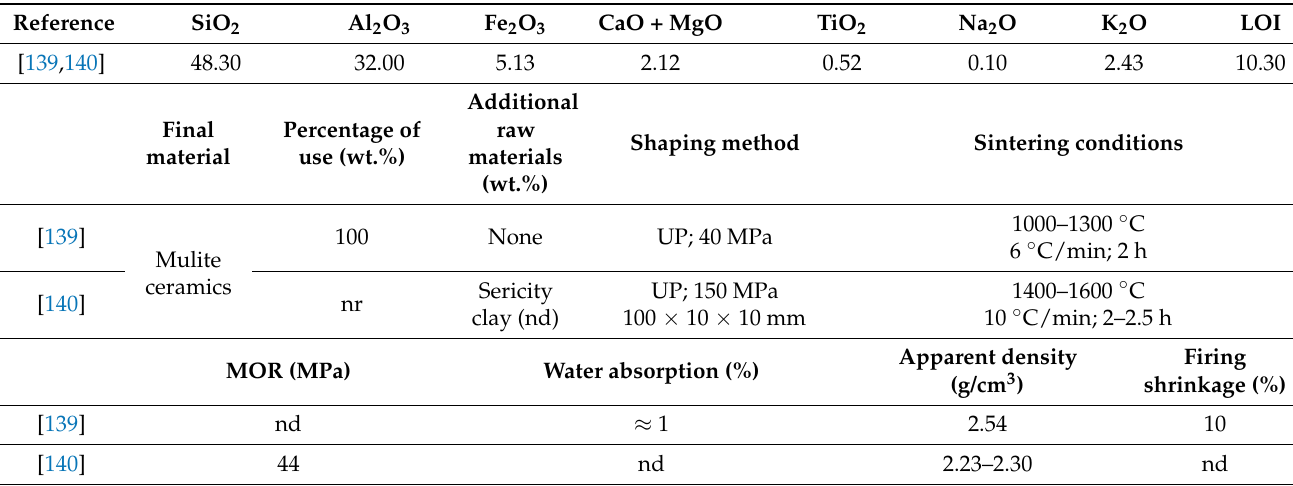
Table 18. Chemical composition (expressed wt.% oxide), processing parameters and technological properties of ceramic materials developed from granitic sand washing